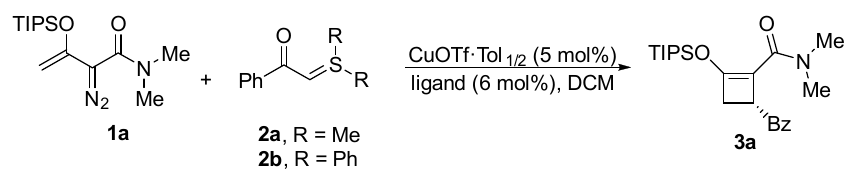
Scheme 1. Ligands employed in the search for enantioselectivity in the [3 + 1]-cycloaddition reactions of enoldiazoacetamide 1a .